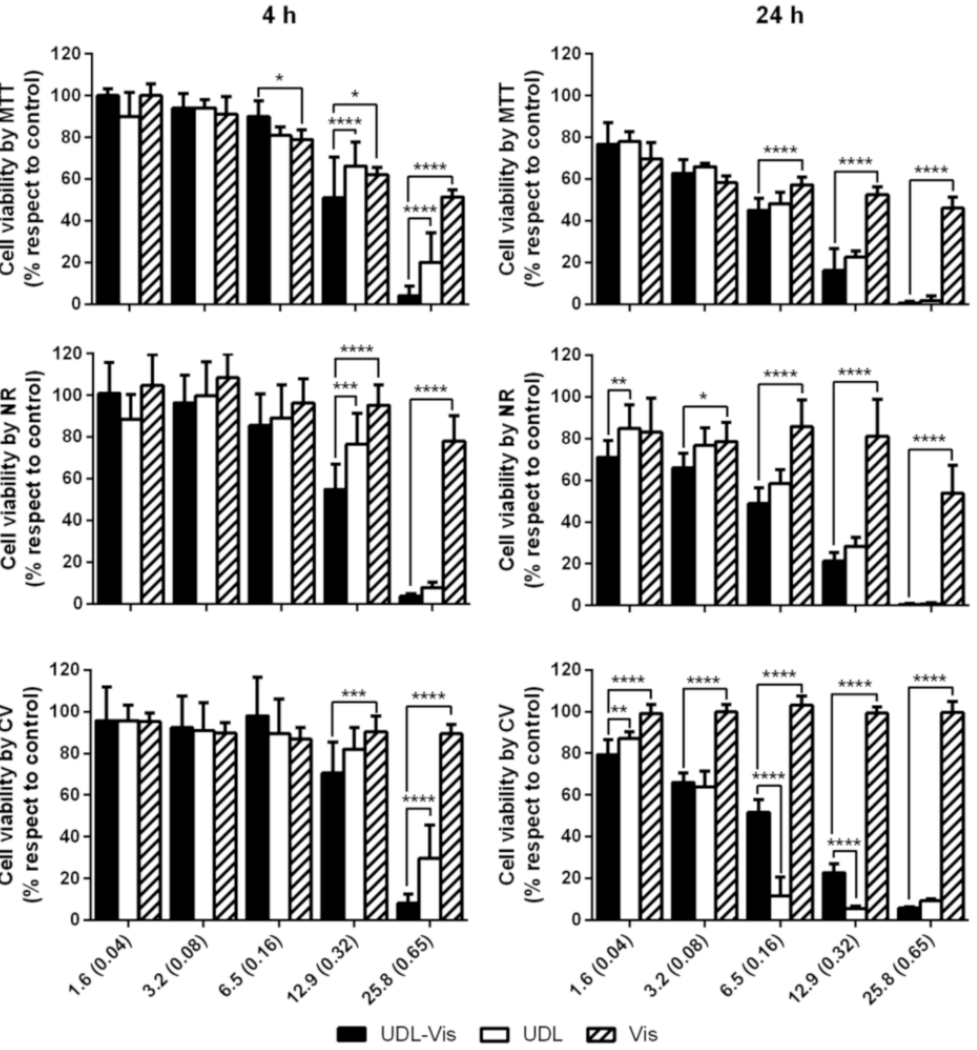
Figure 4. Percentage of cell viability of SK-Mel-28 after ( 4 h ) and ( 24 h ) of incubation with UDL, UDL-Vis, and free Vismodegib (Vis) as determined by MTT, neutral red (NR), and crystal violet (CV). Concentrations are expressed as the concentration of SPC in mM and within the parenthesis the concentration of Vismodegib in mg/mL. Data are presented as mean ± SD ( n = 3). Statistical analysis is only shown in those concentrations in which the changes were significant with respect to the control (determined by one-way ANOVA analysis). * p < 0.05, ** p < 0.01, *** p < 0.001, **** p <